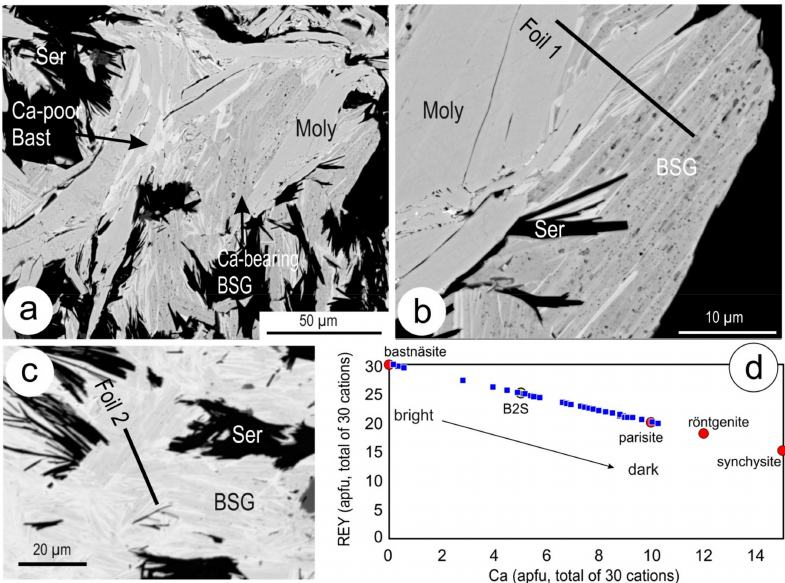
Figure 2. ( a – c ) Back Scatter Electron (BSE) images showing bastnäsite-synchysite group (BSG) phases as lamellar aggregates intergrown with molybdenite (Moly) and sericite (Ser). Location of focused ion beam (FIB) cuts from where transmission electron microscopy (TEM) foils were obtained is shown in ( b , c ); ( d ) Plot REY vs. Ca from electron probe microanalyzer (EPMA) data showing the compositional range of analysed phases shown in ( a – c ) within the BSG